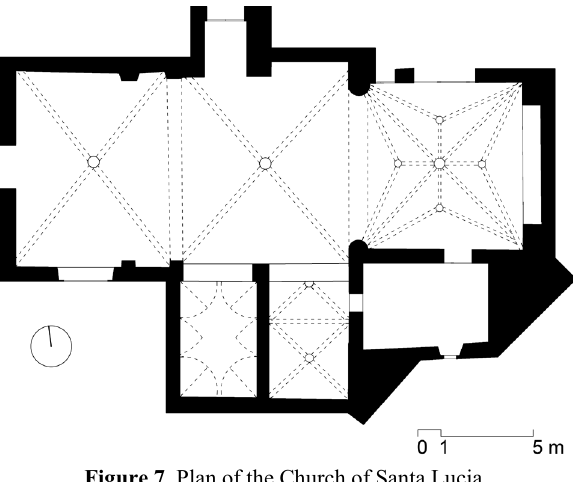
Figure 7 . Plan of the Church of Santa